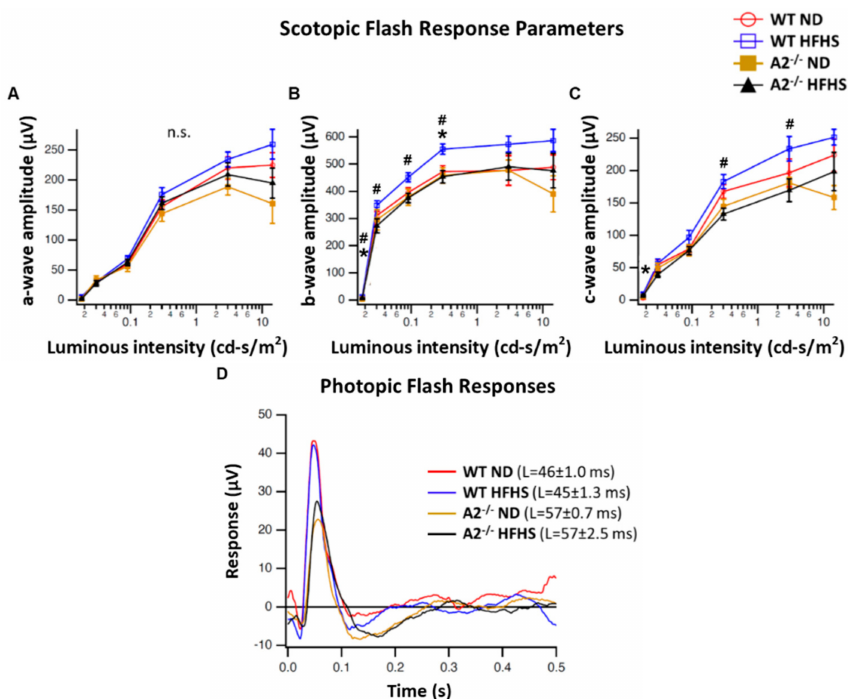
Figure 6. Electroretinogram (ERG) responses were recorded after overnight dark adaptation from mice in scotopic conditions and amplitudes were analyzed as a function of light intensity ( n = 5 per group). Scotopic flash responses are provided for the a-, b-, and c-wave ERG components ( A – C , respectively). Mean amplitudes with standard errors are plotted against luminance for each group. Averaged photopic responses ( D ) evoked by brief (5 ms) flashes are shown for each group. * p < 0.05 for the di ff erence between the WT HFHS and WT ND groups, # p < 0.05 for the di ff erence between the WT HFHS and A2 − / − HFHS groups.